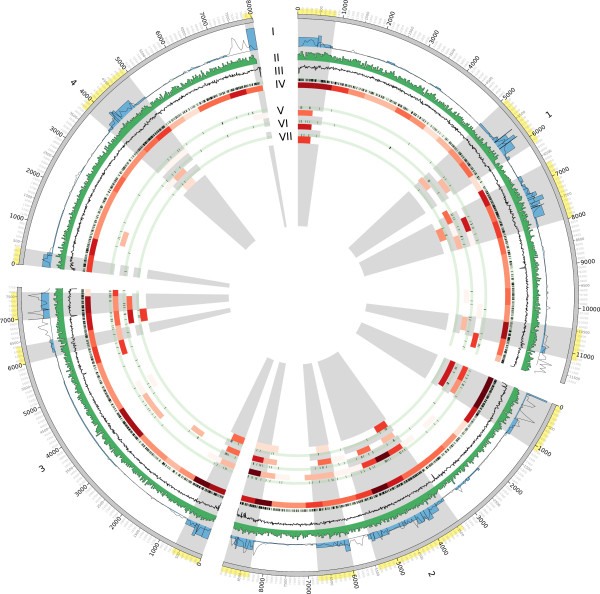
Distribution of predicted protein clusters across the F. graminearum genome. A Circos plot [62] is shown which visualizes the four F. graminearum chromosomes with ticks in kilobase (Kbp) units. The following bands for F. graminearum are visualized: (I) Recombination frequency (blue bars) and SNP density (line), (II) gene density, (III) GC content, (IV) set of 2830 pathogen-associated proteins, (V) protein cluster C7, (VI) protein cluster C8, (VII) proteins with the [SG]-P-C-[KR]-P motif. For each gene set, the location of the genes on the chromosomes and a heatmap in red shading for the gene count in 500 Kbp bins are shown. It can be seen that proteins from putative effector clusters C7 and C8 occur predominantly in regions of genome innovation.